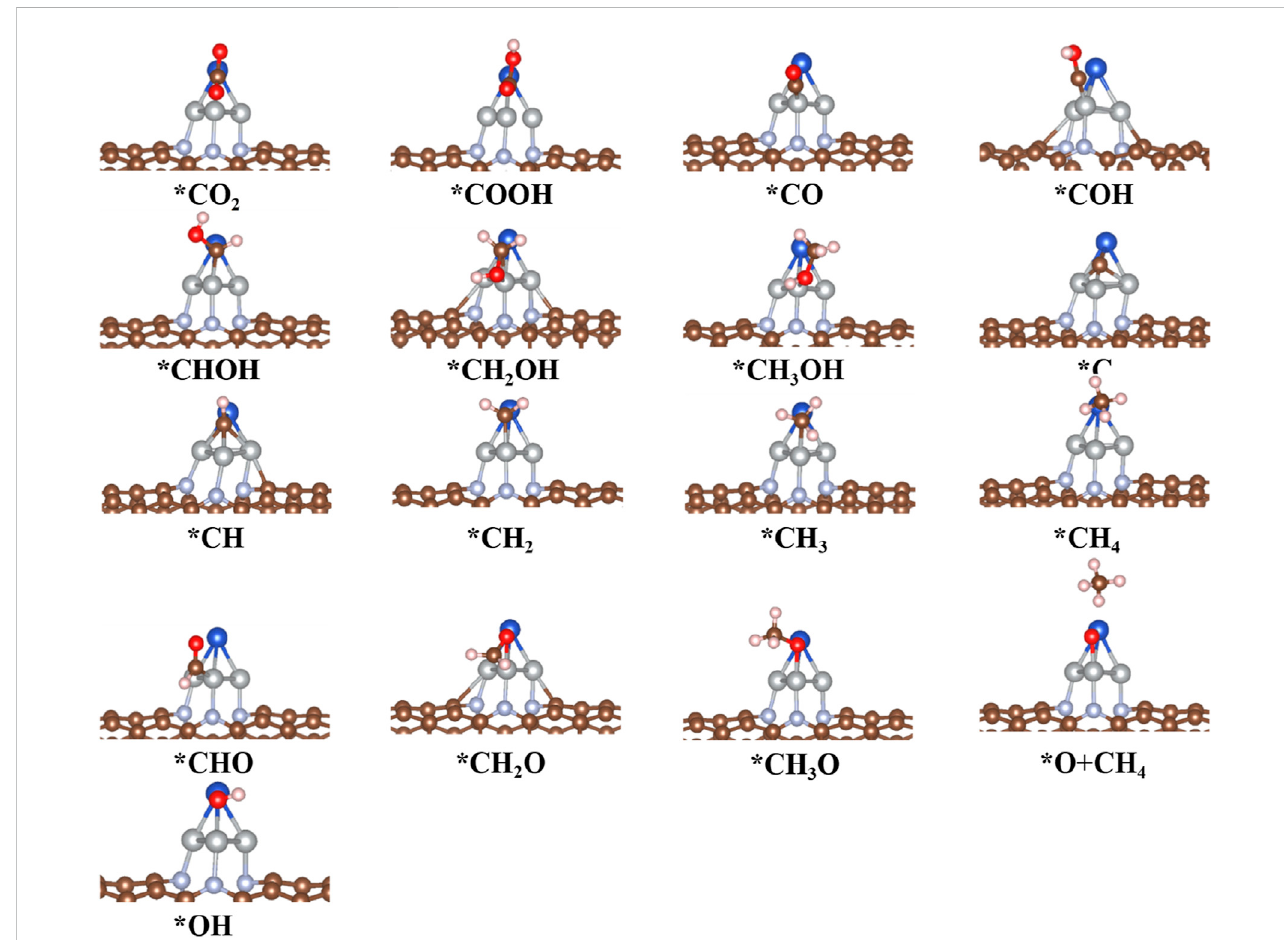
FIGURE 9 Optimized structure of intermediates for CO 2 RR on the CuNi 3 @CNT surfaces.